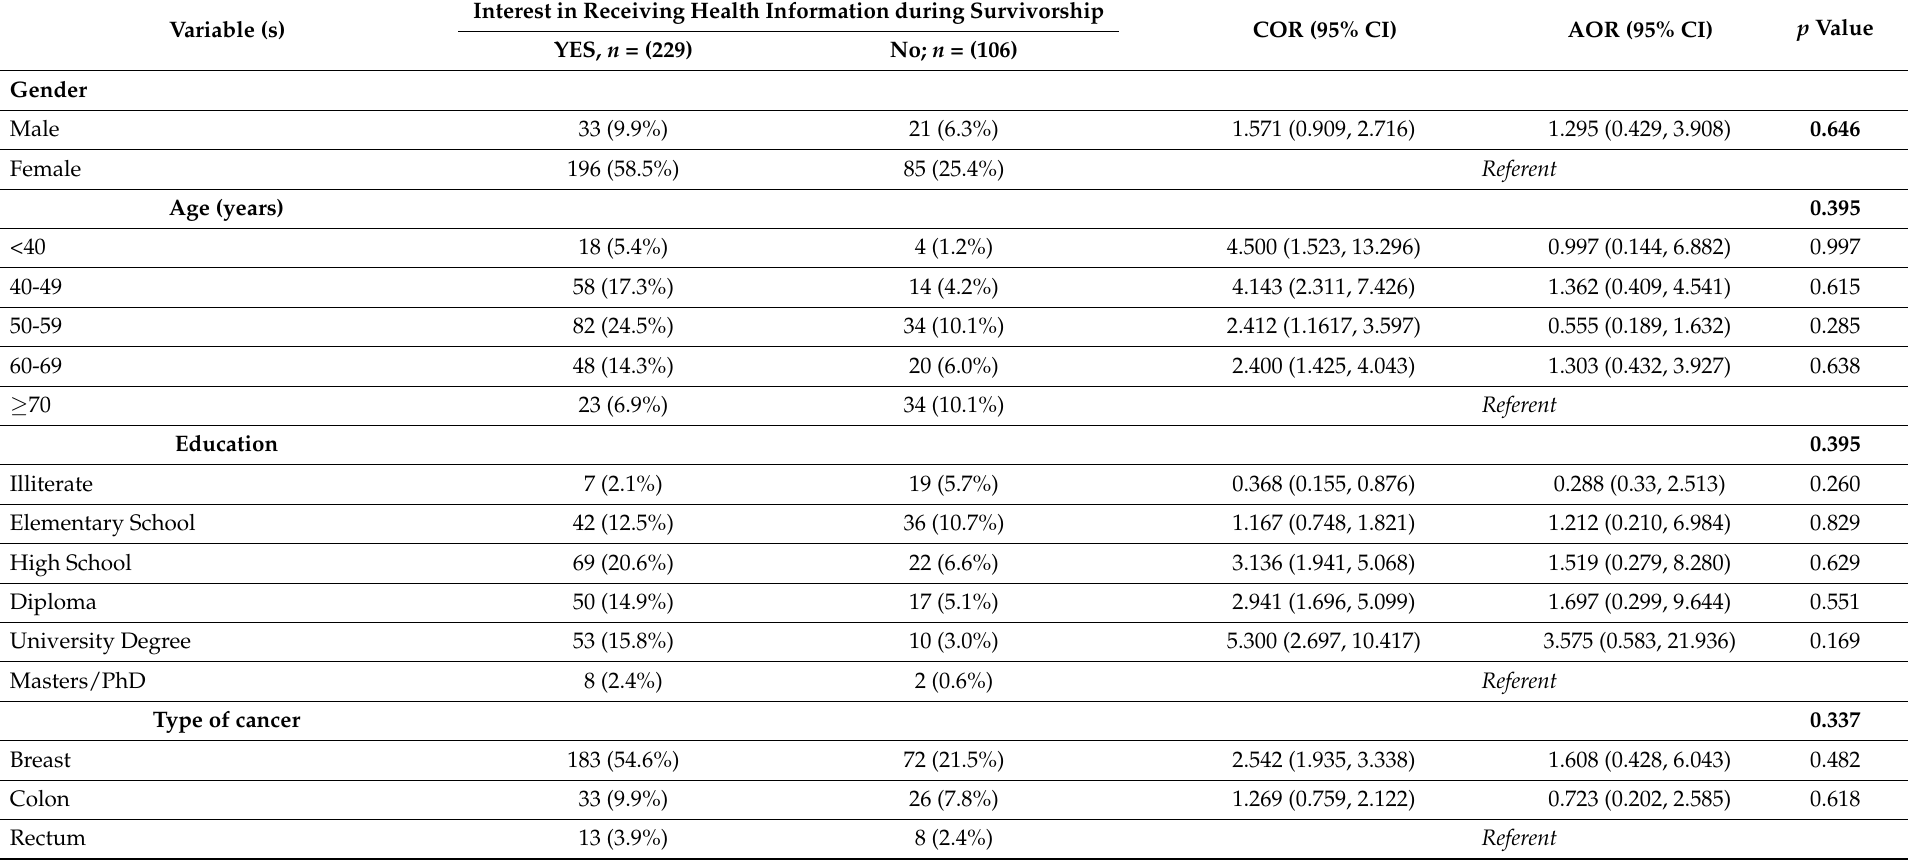
Table 6. Predictors of online information interest across the cancer continuum among breast and colorectal cancer survivors, Jordan 2020, * p -value < 0.05 indicates statistical